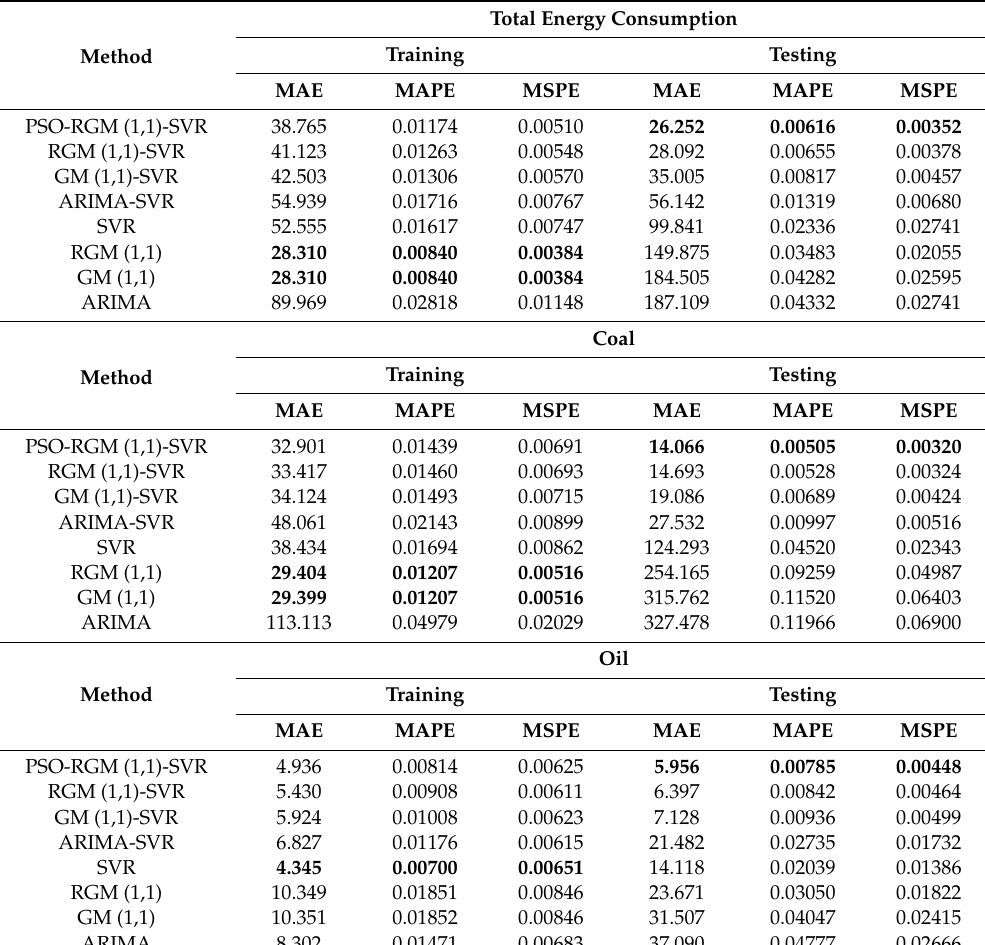
Table 13. Model evaluation